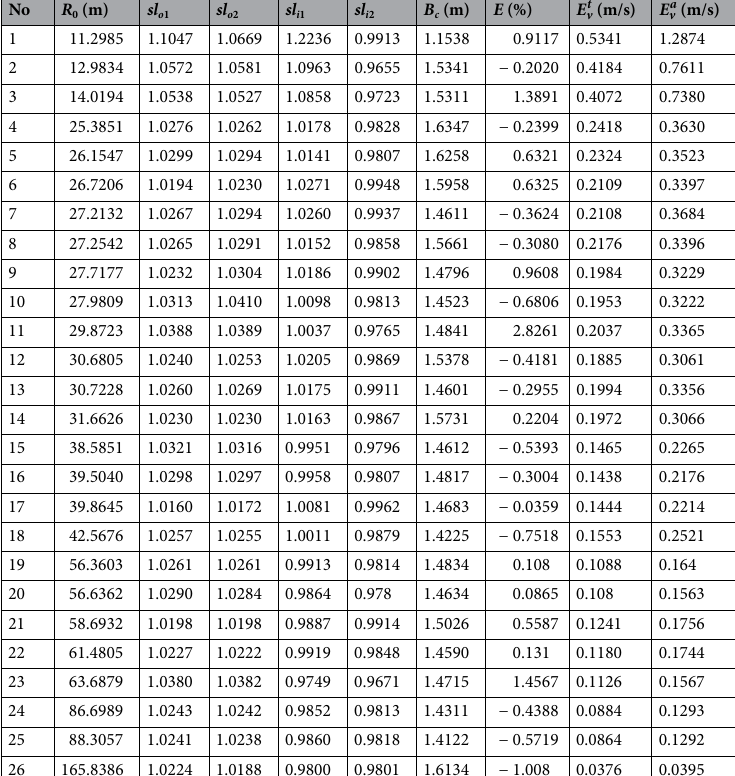
Table 5. Data record about the UGV turning experiments.